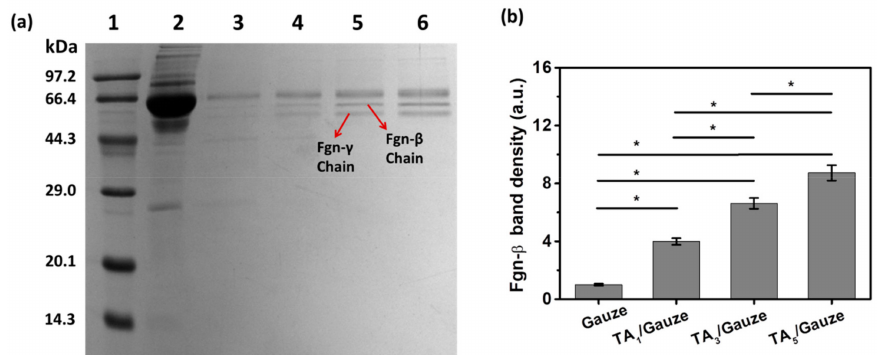
Figure 4. Adsorption behaviors of plasma proteins analyzed by SDS-PAGE. ( a ) SDS-PAGE results for plasma protein adsorbed on gauze and TA-coated gauze. Lane 1: marker. Lane 2: 1% rabbit plasma (PBS diluted). Lane 3: gauze. Lane 4: TA-coated gauze (1 cycle). Lane 5: Fe-TA-coated gauze (3 cycles). Lane 6: Fe-TA-coated gauze (5 cycles). Arrows indicate Fgn- β or Fgn- γ chain; ( b ) Fgn- β band density calculated from the gray color depth of the SDS-PAGE result. Fgn- β band density on the gauze (lane 3) is defined as 1. Mean ± SD. Statistical analysis was performed with a one-way ANOVA test, *: p < 0.05.